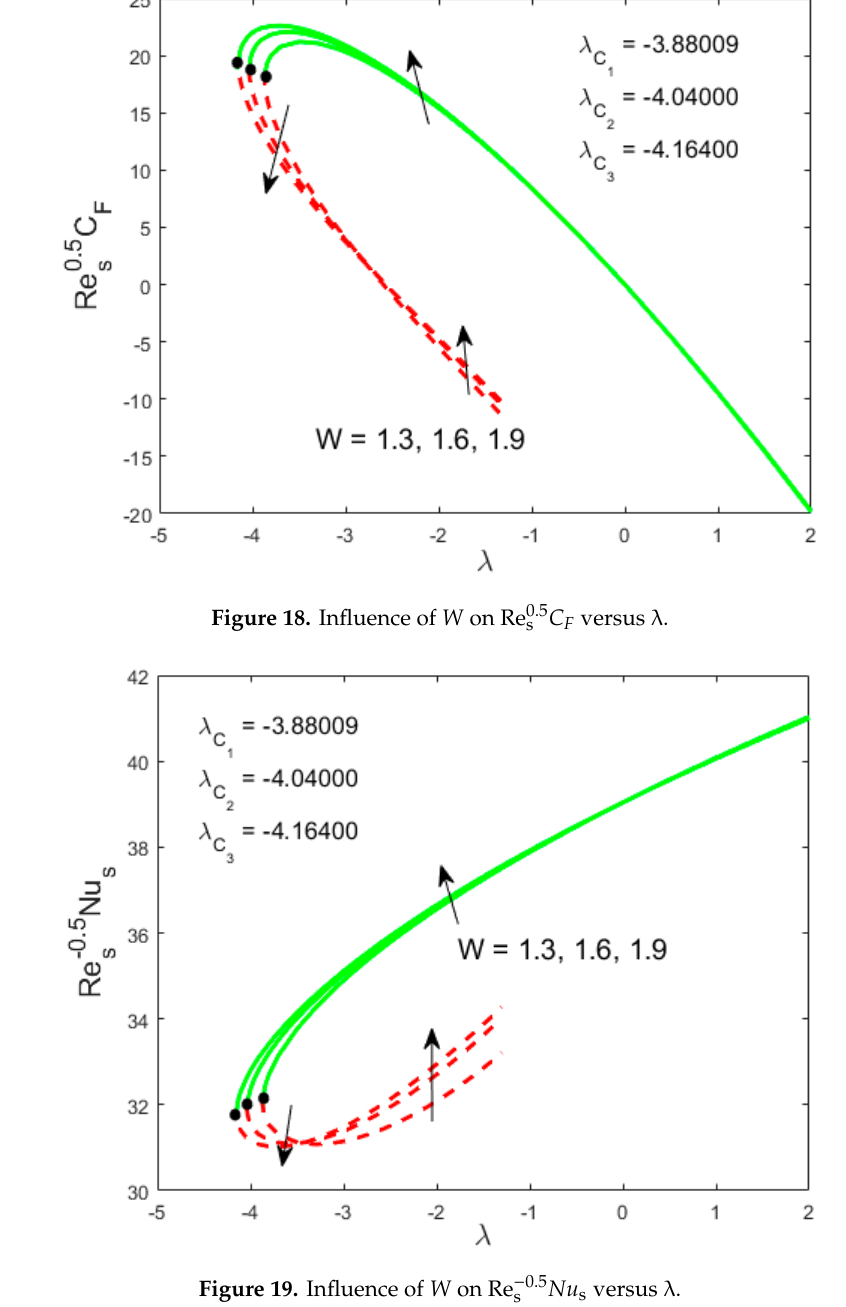
Figure 19. Influence of W on